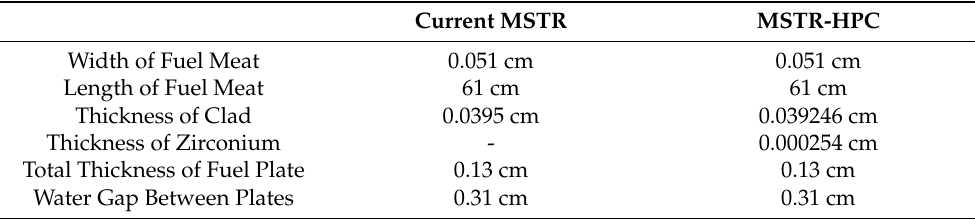
Table 1. Dimensions comparison of fuel plate for current MSTR and